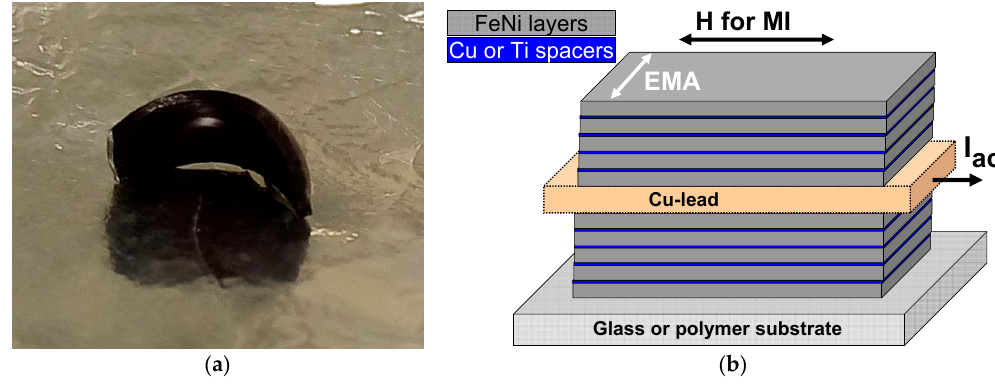
Figure 1. General view of FG-I-1 ferrogel 9 mm × 2 mm × 1 mm piece after 40 min drying in ambient